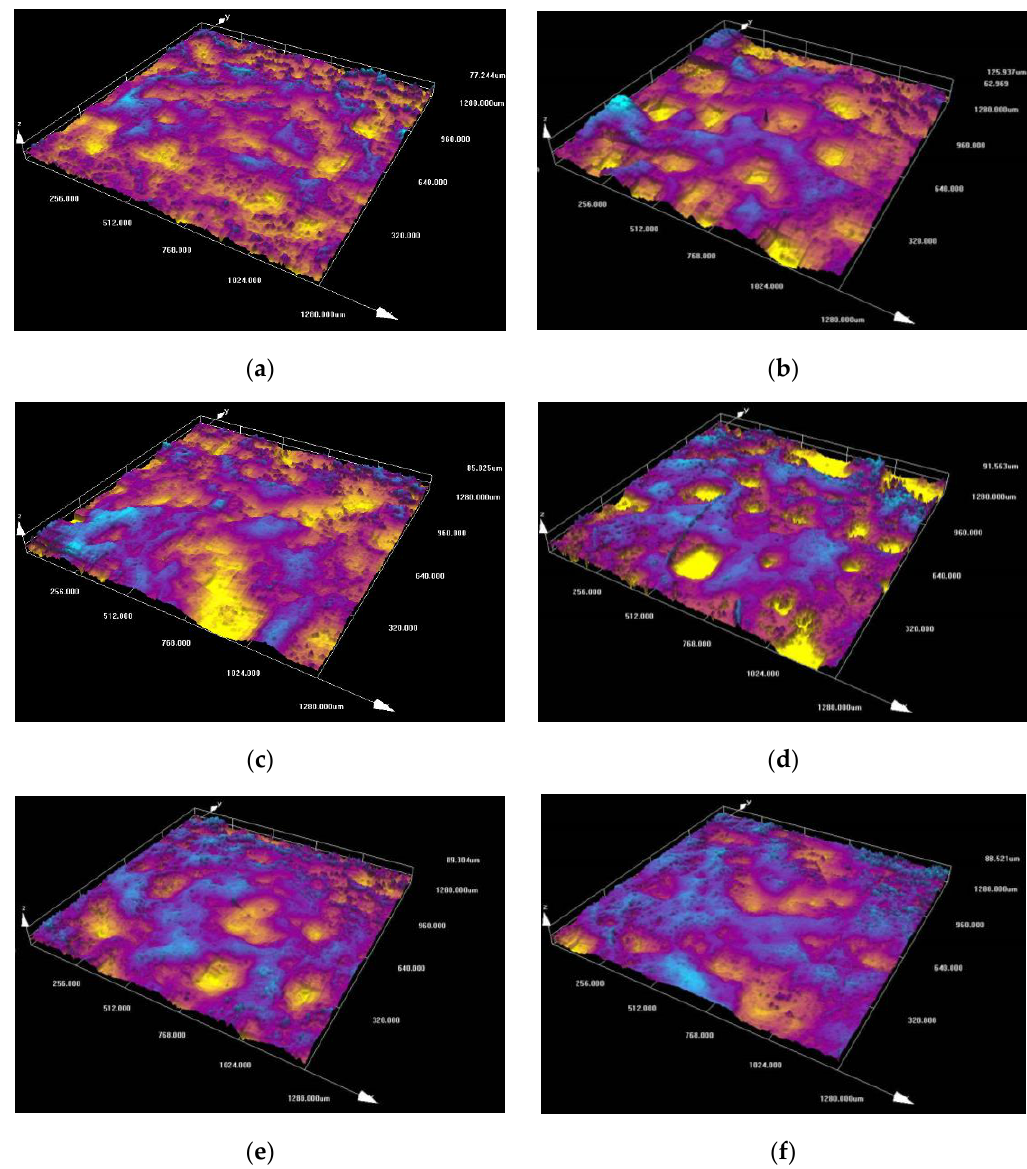
Figure 11. Three-dimensional surface morphology of the samples under different target distances: ( a ) target distance of 25 mm; ( b ) target distance of 30 mm; ( c ) target distance of 35 mm; ( d ) target distance of 40 mm; ( e ) target distance of 45 mm; ( f ) target distance of 50 mm.